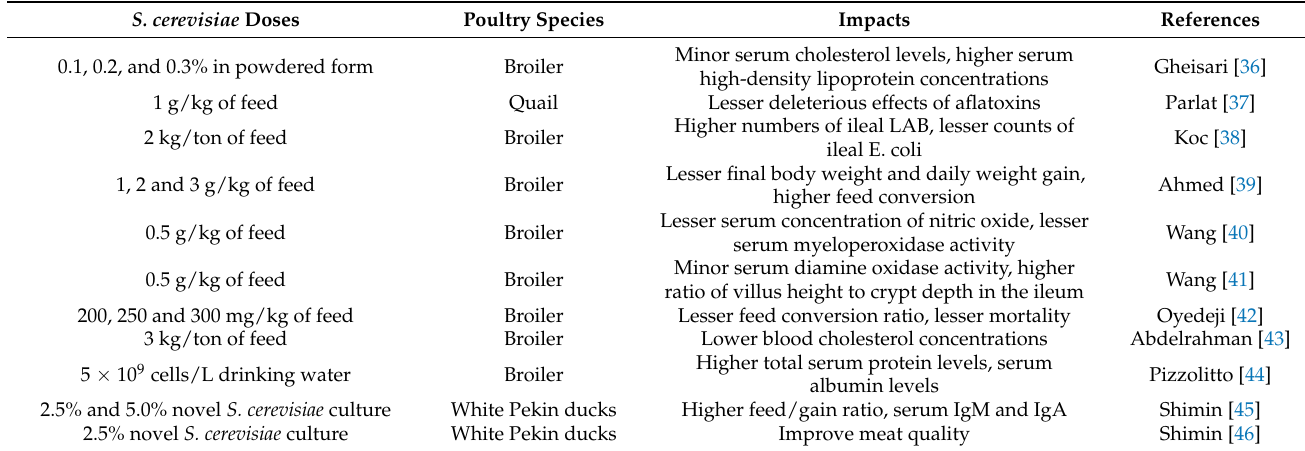
Table 1. Effect of yeast supplementation in poultry diets with Saccharomyces cerevisiae